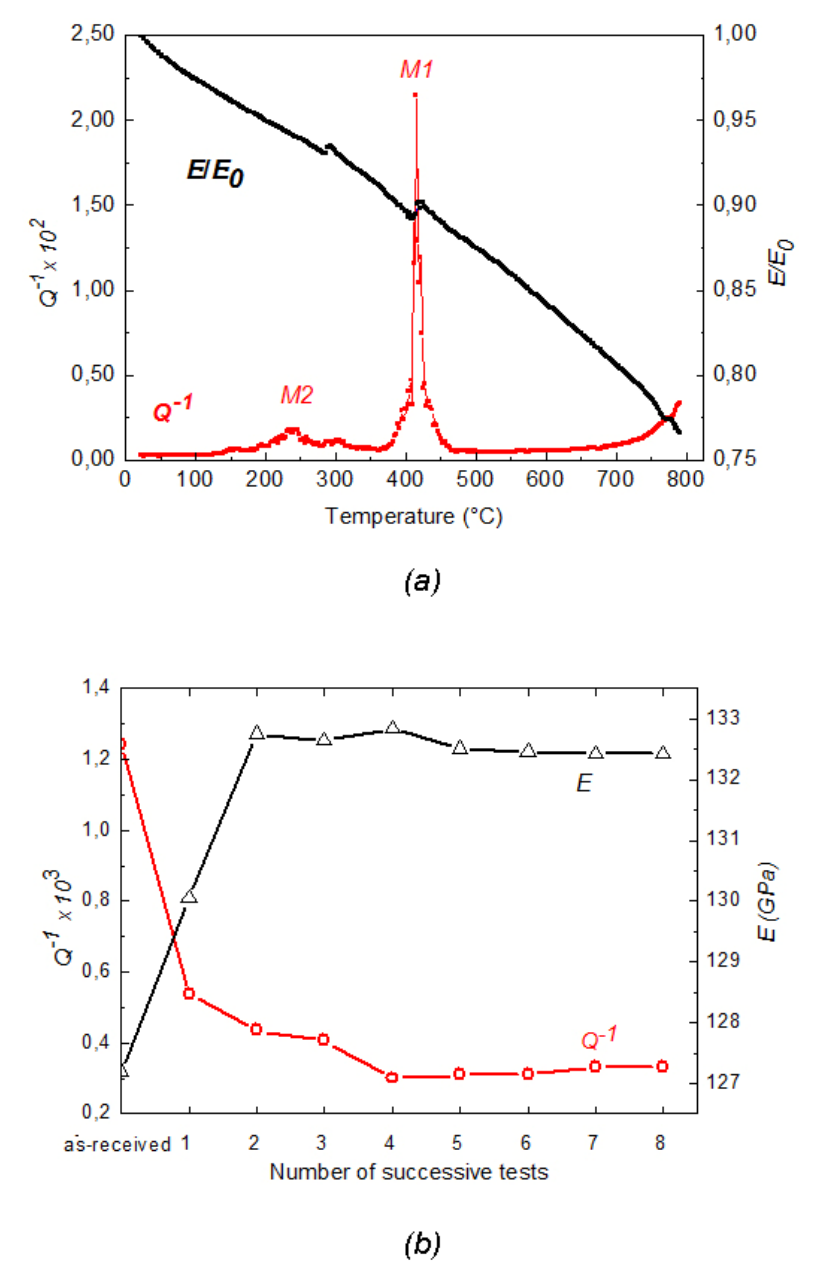
Figure 4. Q − 1 and E/E 0 vs. temperature in the first test run ( a ); Q − 1 and E after successive MS test runs ( b ). Such phenomena are connected to the growth of cells forming the dislocation networks of PFZ, which are not observed after some cycles of heating and cooling. Such growth occurs by coalescence